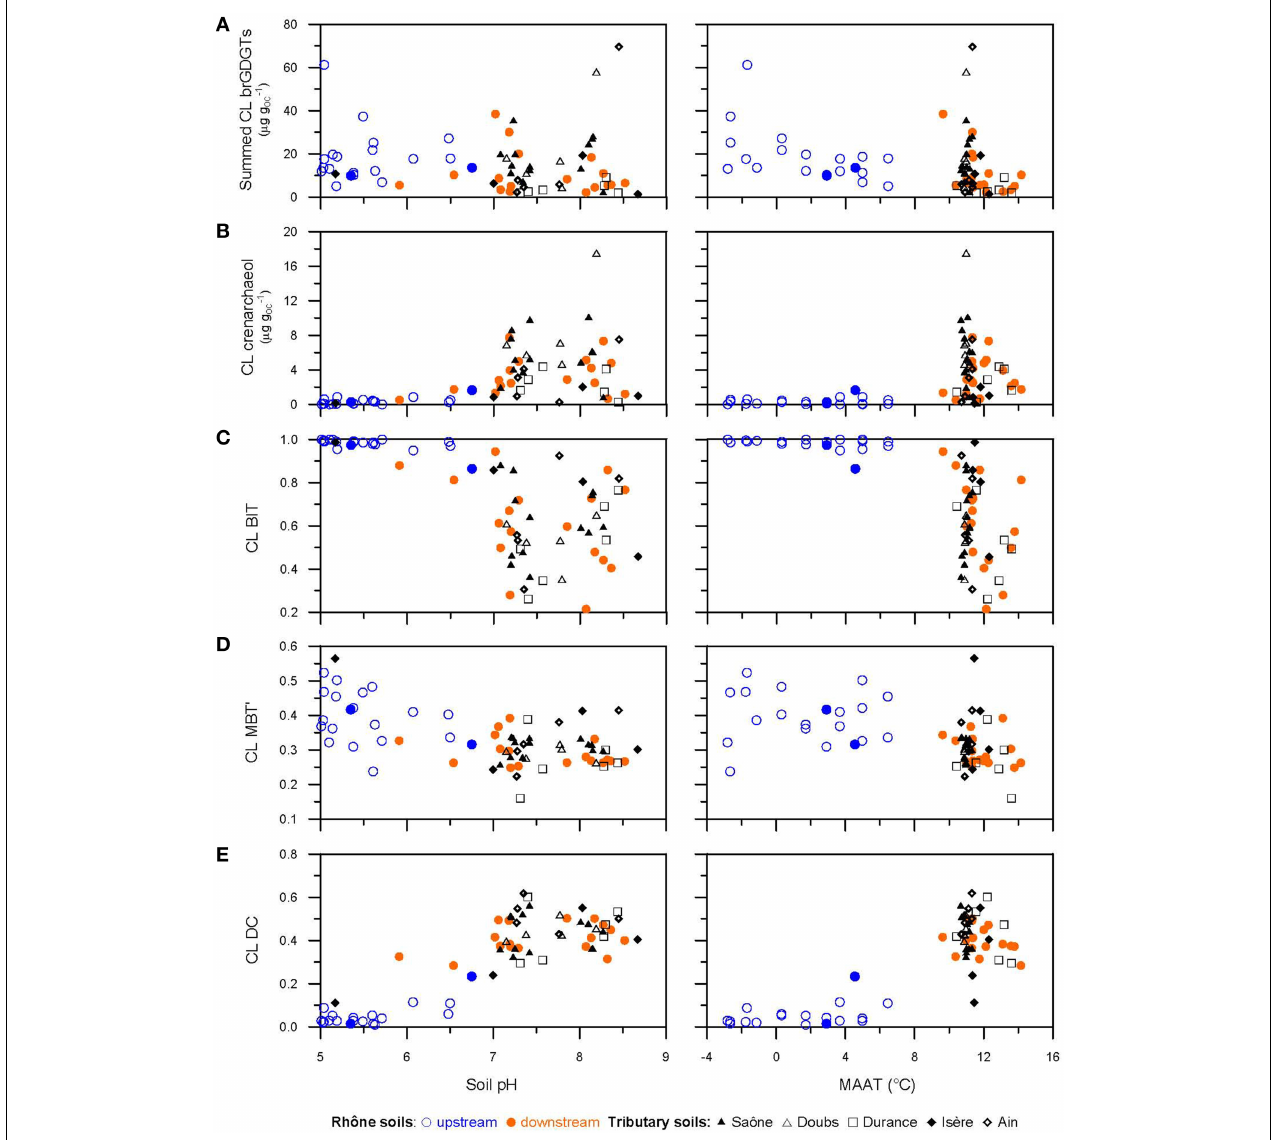
soils. Note that the data of the Fiesch soil transect in the upper Rhône River basin are indicated as open blue circles, while others as filled blue